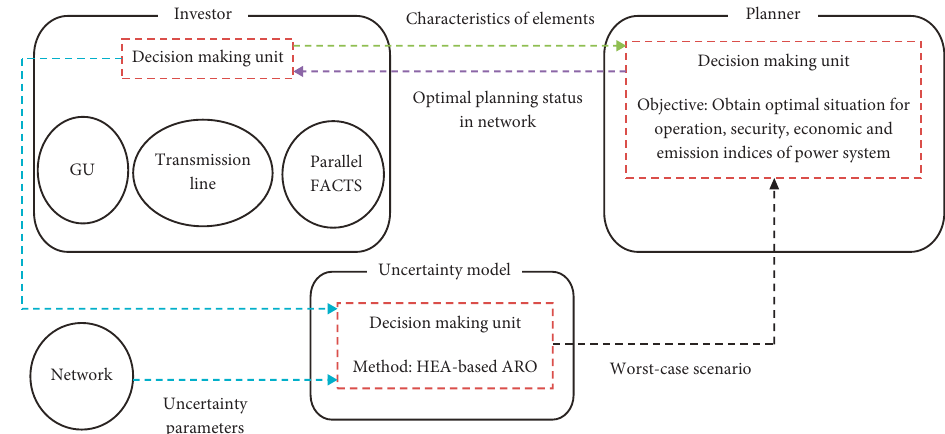
Figure 1: Proposed GTEP